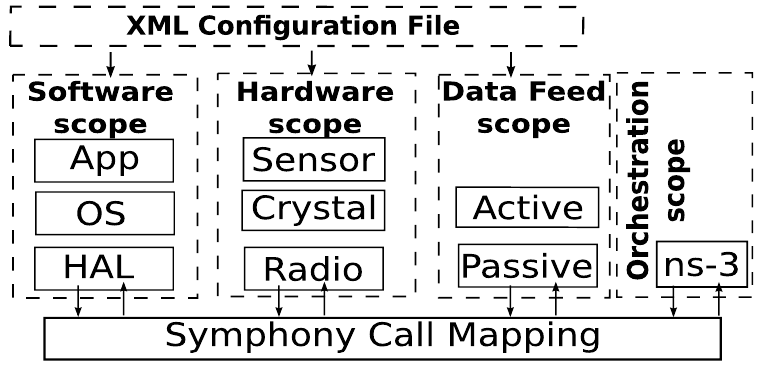
Figure 2. Architecture of the Symphony